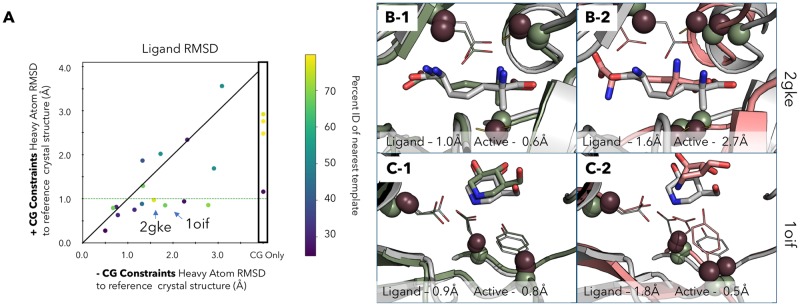
Docking with and without CG constraints.A Ligand RMSD over all heavy atoms in the ligand versus the reference crystal structure ligand. The y-axis are RMSD of the CG constraint added models, the x-axis are RMSD of the standard models. Points below the diagonal are improved with the addition of CG constraints. Points on the line are not affected and points above the line are worse with the addition of CG constraints. The green line marks the 1Å RMSD cutoff for the models made with CG constraints. On the x-axis there are 4 targets that were unable to find a solution without the addition of CG constraints (CG only). Targets are colored by the difficulty based on sequence homology of the closest template used for modeling. 2 targets are not shown as they were unable to identify solutions in either case. B-1 Docking results for target 2gke with CG constraints, crystal structure (grey) overlaid with model (green). B-2 Docking results for target 2gke without CG constraints, crystal structure (grey) overlaid with model (red). C-1 Docking results for target 1oif with CG constraints, crystal structure (grey) overlaid with model (green). C-2 Docking results for target 1oif without CG constraints, crystal structure (grey) overlaid with model (red).